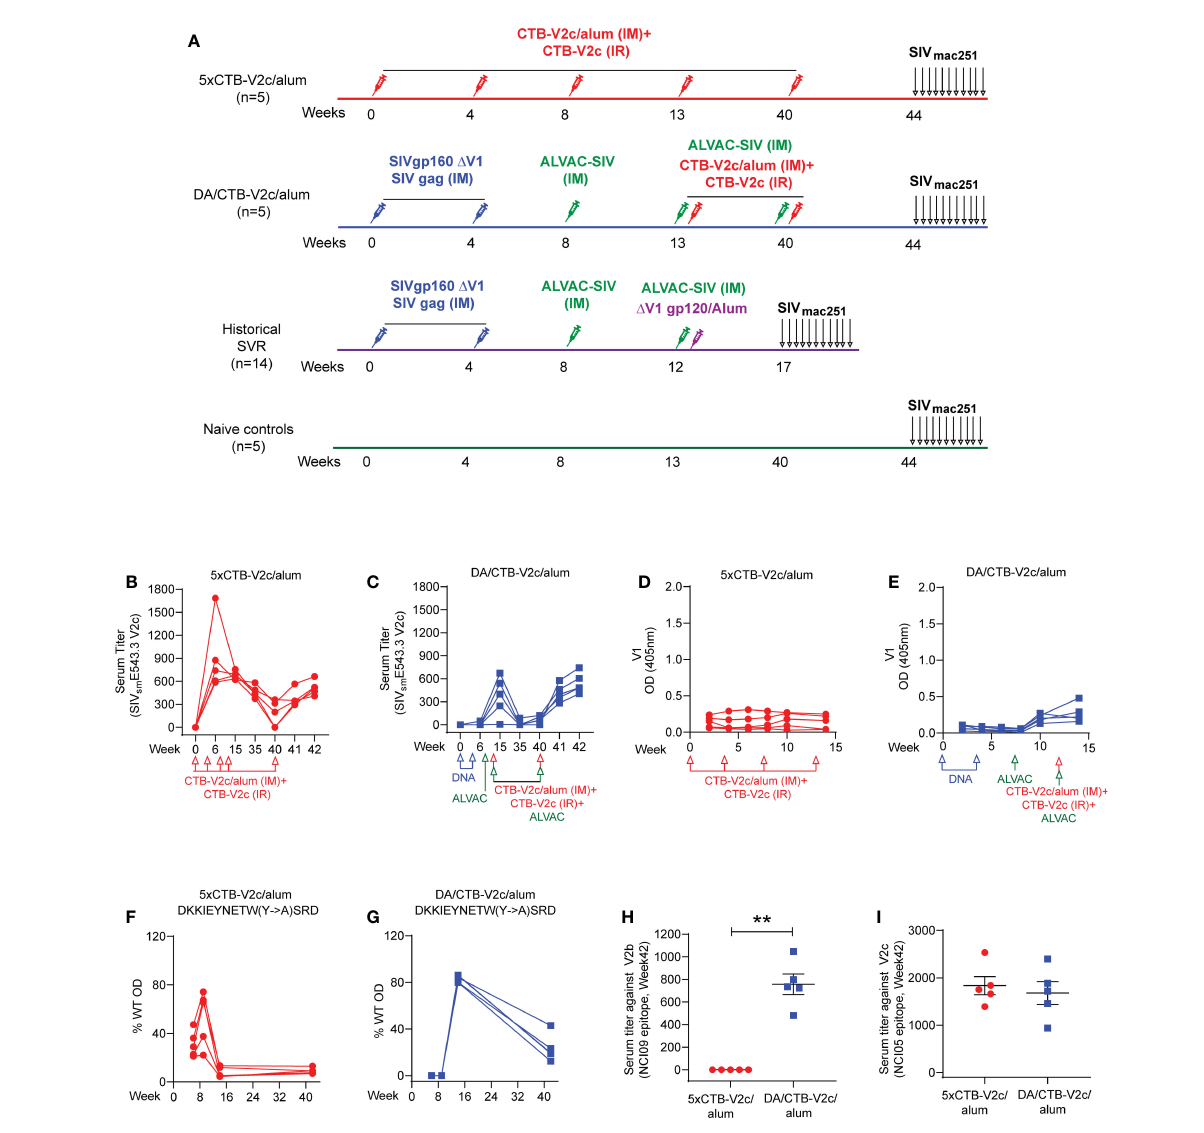
and signi fi cantly higher than in the SVR (Figure 3B). In contrast, V2b-speci fi c ADCC revealed by NCI09 F(ab ’ )2 was lower in the 5xCTB-V2c/alum group (Figure 3C) as expected, since the V2b epitope was not included in the 5xCTB-V2c/alum vaccine regimen and the ADCC response could therefore only be elicited from the